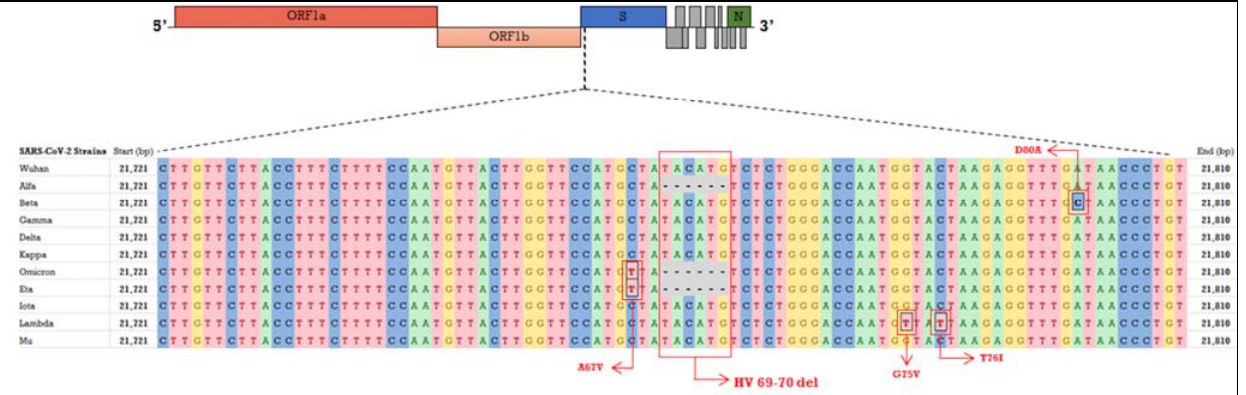
Figure 2. Focused alignment of the genomic sequence encompassing the HV69 ‐ 70del within the S gene. The SARS ‐ CoV ‐ 2 genome has been schematized and the genes/regions targeted by the TaqPath COVID ‐ 19 RT PCR CE IVD kit, namely Orf1ab , S and N have been highlighted. The nucleotide sequence encompassing the HV69 ‐ 70 deletion and 40 bp upstream and downstream within the S gene is shown and aligned among the VOCs (Alpha, Beta, Gamma, Delta and Omicron) and other variants of interest (Eta, Iota, Kappa, Lambda and Mu). The occurrence of the HV69 ‐ 70del responsible for the SGTF can be visualized in Alpha and Omicron among the VOCs and in Eta, among the related variants. Other mutations characterizing viral variants which occurred within the focused sequence are shown as well. The Wuhan original strain was used as reference genome and the related sequence was retrieved from NCBI (NC_045512.2, https://www.ncbi.nlm.nih.gov, accessed on 8 February 2022). Data on variants’ mutational landscape were obtained from Nextrain.org, CoVariants (https://covariants.org/variants/, accessed on 8 February 2022) and UCSC (https://genome.ucsc.edu, accessed on 8 February 2022).